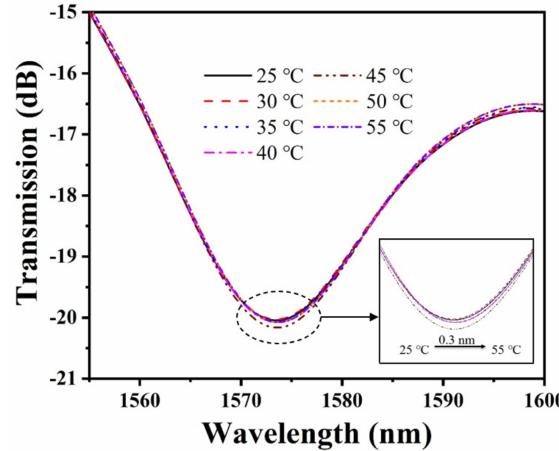
Figure 9. Temperature response of the pH sensor.